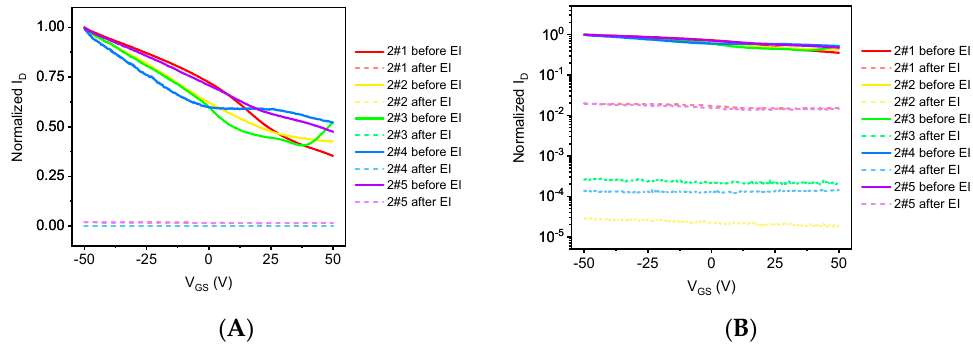
Figure 9. The transfer characteristic curve of graphene samples before and after electron irradiation. ( A ) Linear coordinates and ( B ) Logarithmic coordinates.